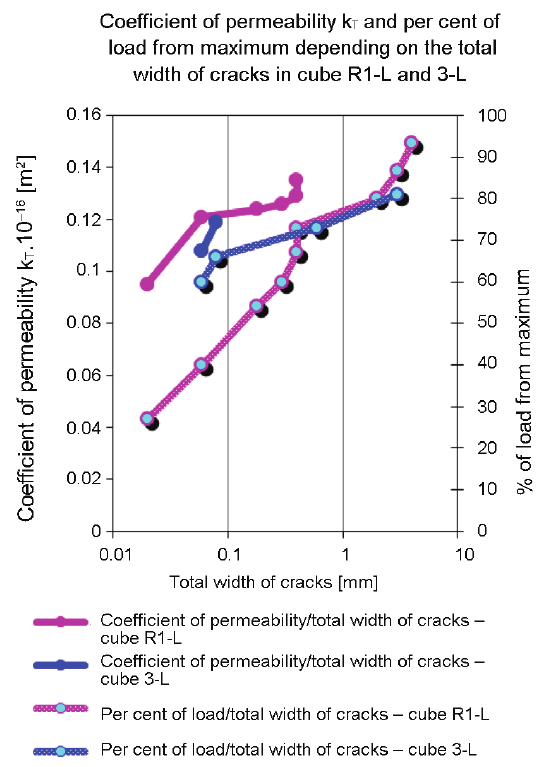
Fig. 12. Monitored dependencies on concrete cube R1-L and